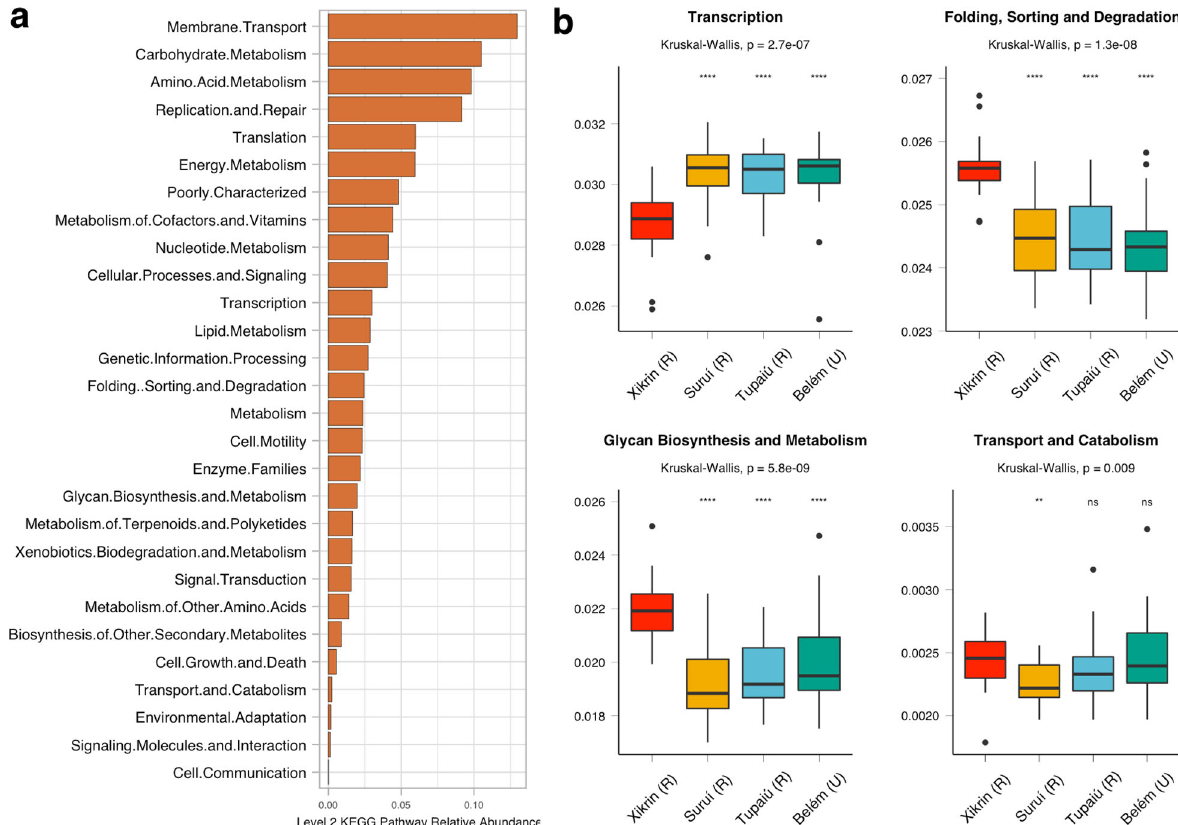
Fig. 6 Functional predictions based on PICRUSt results. a Relative abundance of level 2 KEGG pathways including all samples. b Differentially abundant KEGG pathways as determined by ANCOM ( W > 0.9). NS not signi fi cant, * p ≤ 0.05, ** p ≤ 0.01, *** p ≤ 0.001, **** p ≤